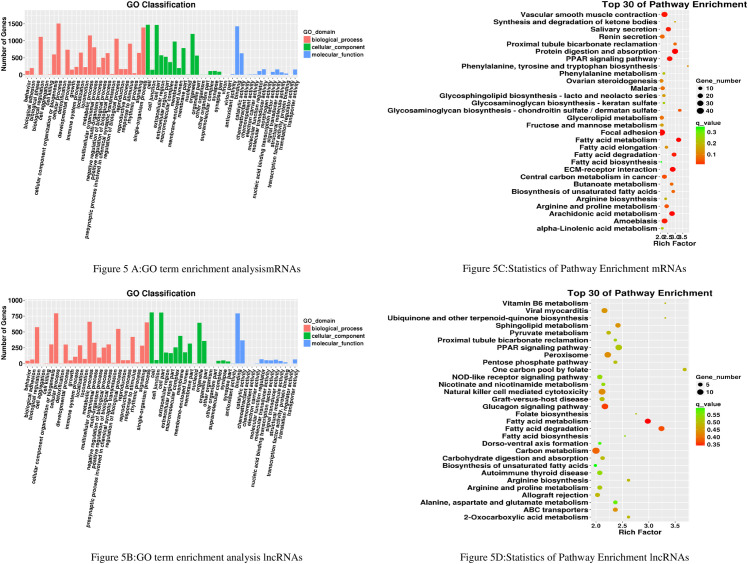
GO and KEGG Analyses of Differentially Expressed lncRNAs target Genes and mRNAs in rats thoracic aorta tissue from the test group and the control group: (5A) GO categories of differential mRNAs in rat heart tissue thoracic aorta tissue from the test group and the control group. (5B) GO categories of differential lncRNA s target genes in rat thoracic aorta tissue from the test group and the control group. (5C) KEGG analysis of differential mRNAs in rat thoracic aorta tissue from the test group and the control group. (5D) KEGG analysis of differential lncRNAs target genes in rat thoracic aorta tissue from the test group and the control group.